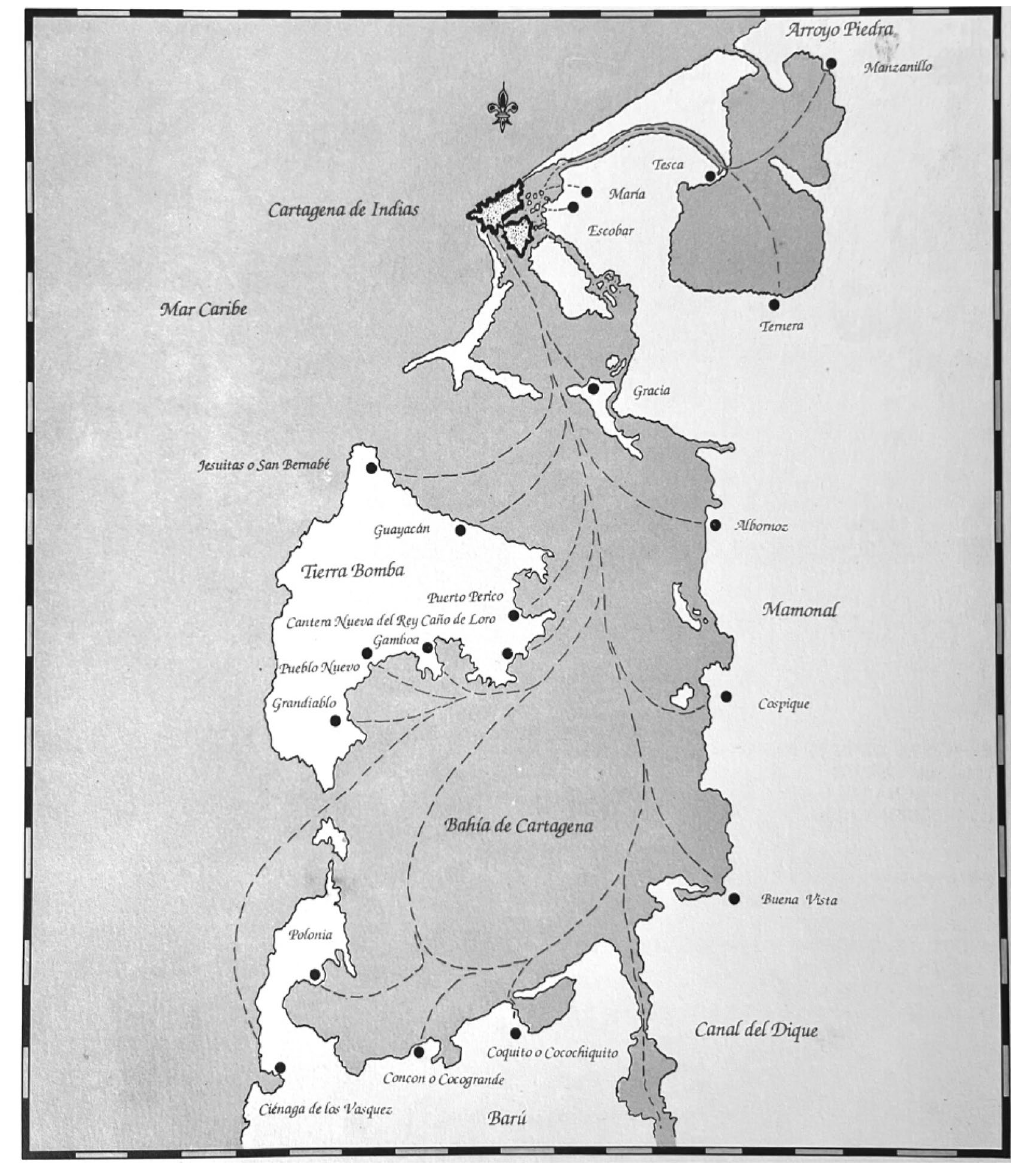
Fig. 9 Quarries and furnaces in the surroundings of Cartagena. Source: Art museum of Cartegena